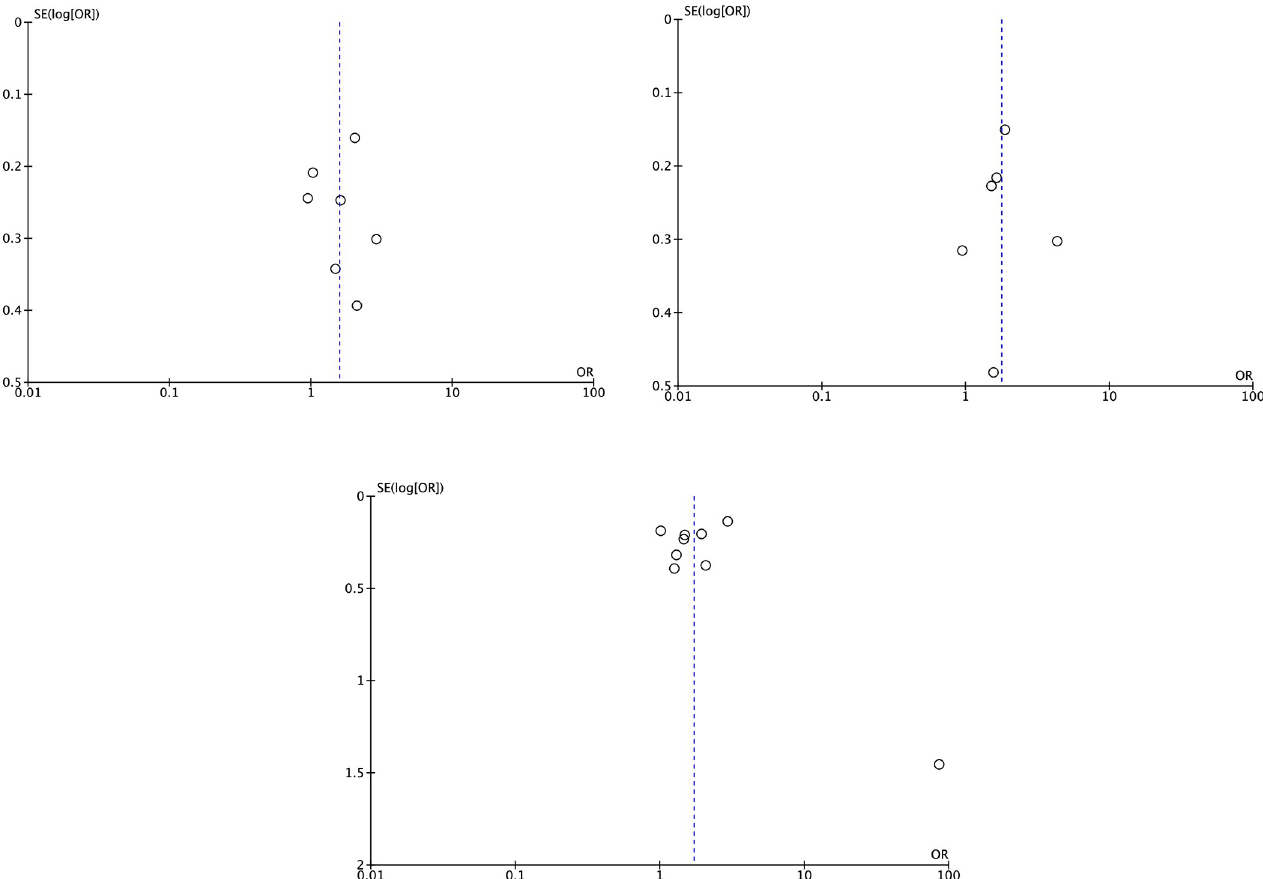
Fig 10. Funnel plots of . (a) knowledge of cancer screening, (b) Intention to Complete Cancer Screening, (c) Completion of Cancer Screening. OR: Odds ratio, SE: standard error, log: